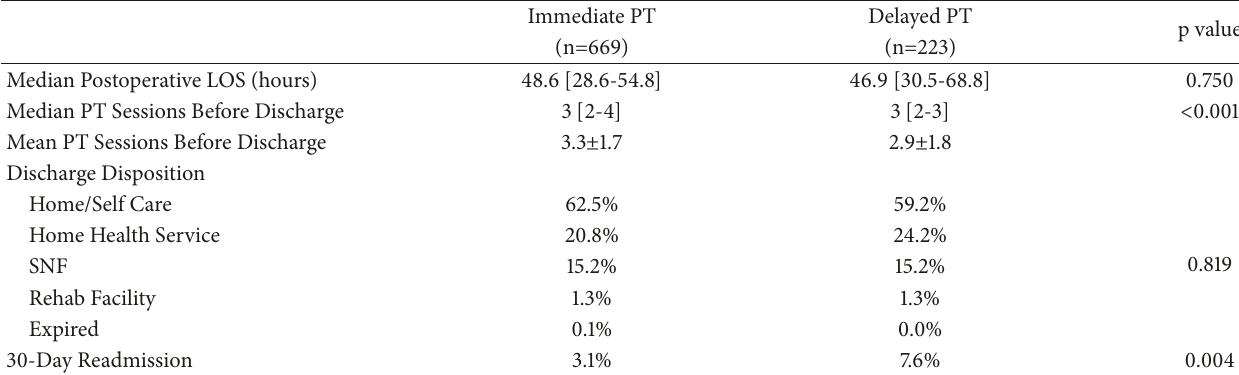
Table 4: Postoperative variables for matched immediate and delayed PT